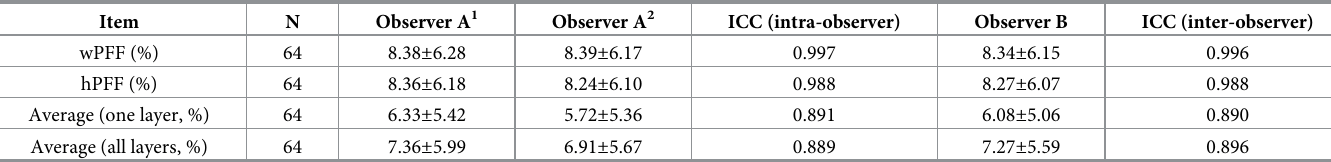
Table 1. Consistency of measured data between the two